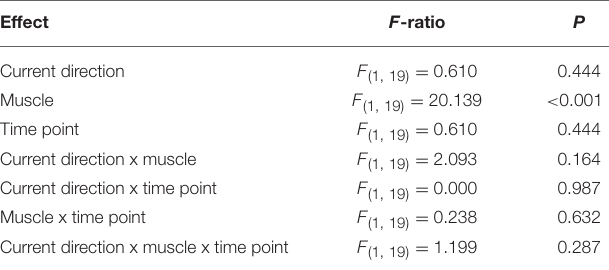
TABLE 3 | ANOVA on absolute MEP amplitudes comparing muscles (FDI, ADM), current directions (PA, AP) and time point (B IT , PG).